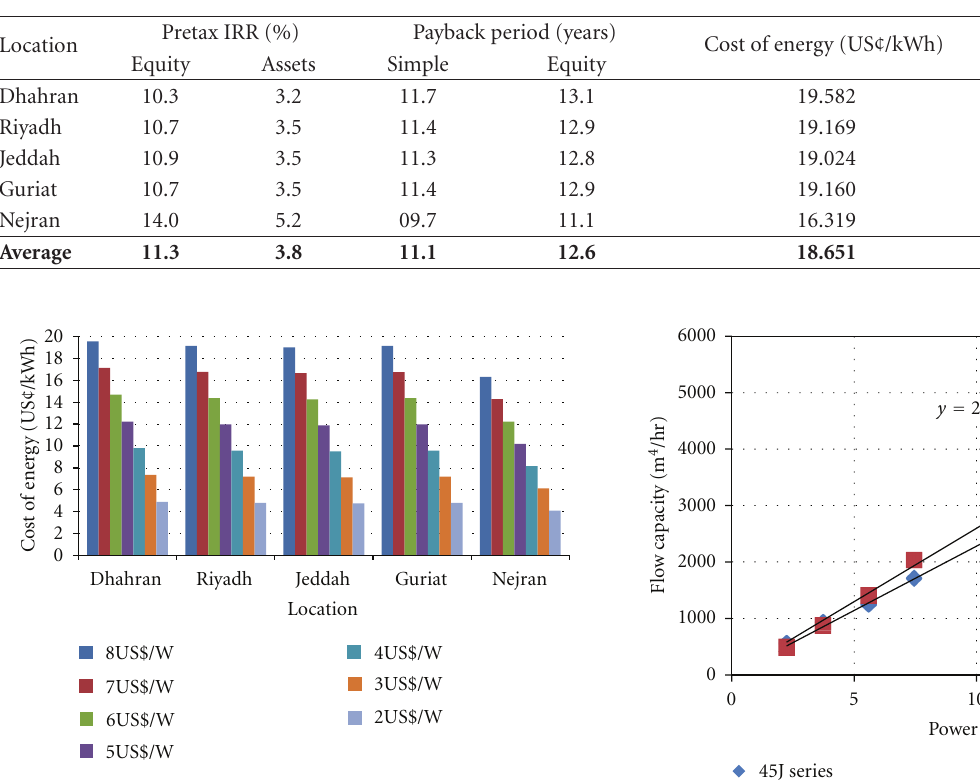
Figure 2: E ff ect of capital cost on cost of energy generated from 9.99kW installed capacity PV power plant in Saudi Arabia.